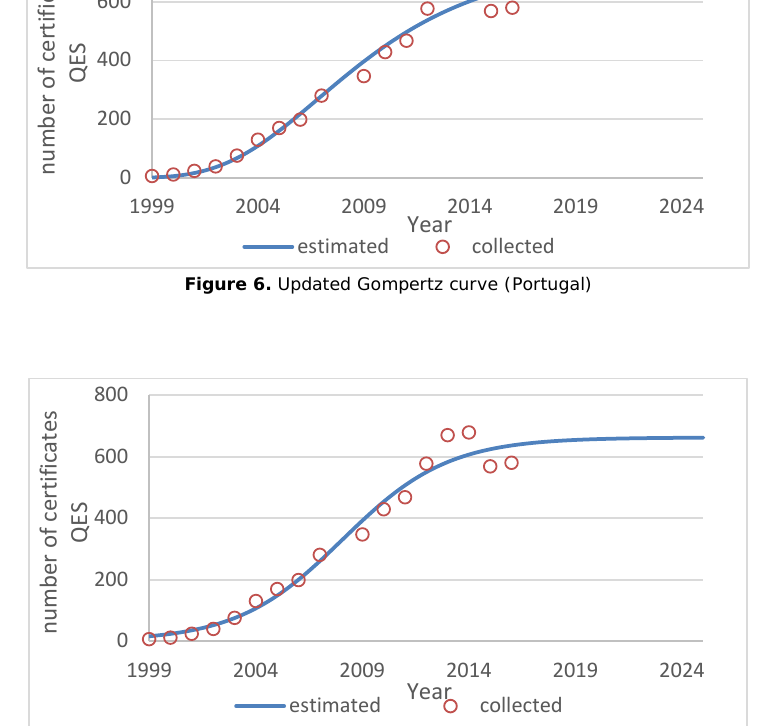
Figure 7. Updated Simple logistic curve